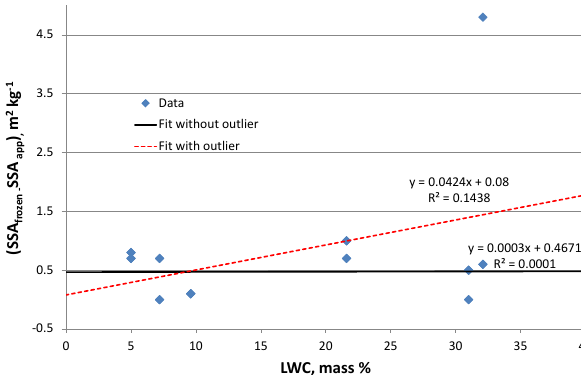
Figure 6. Difference between the SSA of the frozen sample and the apparent SSA of the wet sample (SSA frozen – SSA app ) as a function of